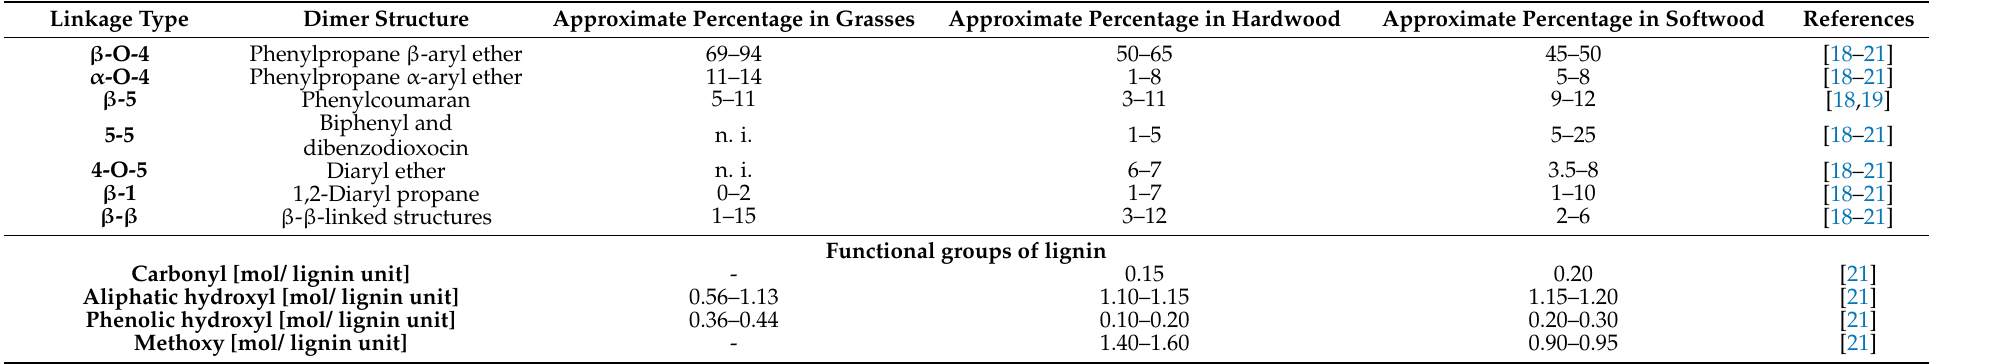
Table 1. Typical bonds of lignin and approximate composition of functional groups for selected lignins.